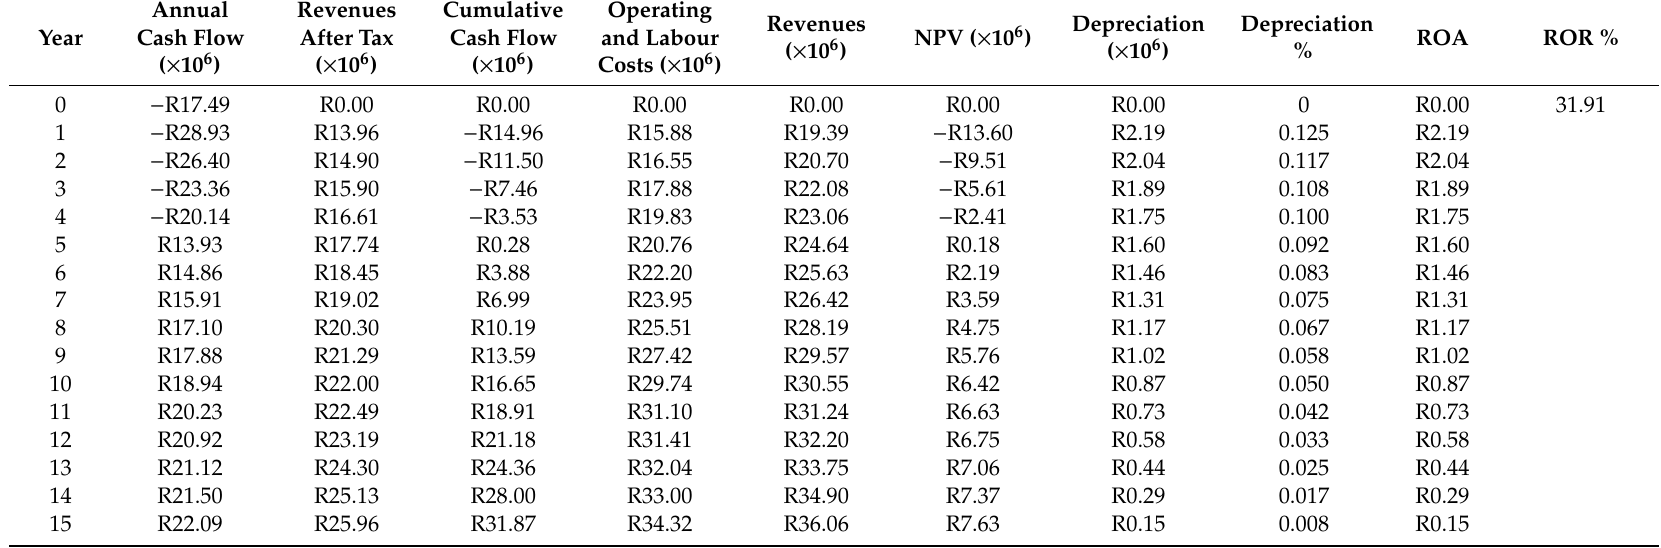
Table 8. Annual project profitability